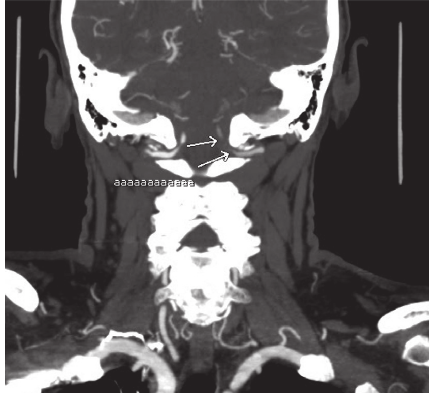
Figure 1: CTA showing left vertebral artery dissection in coronal plane.